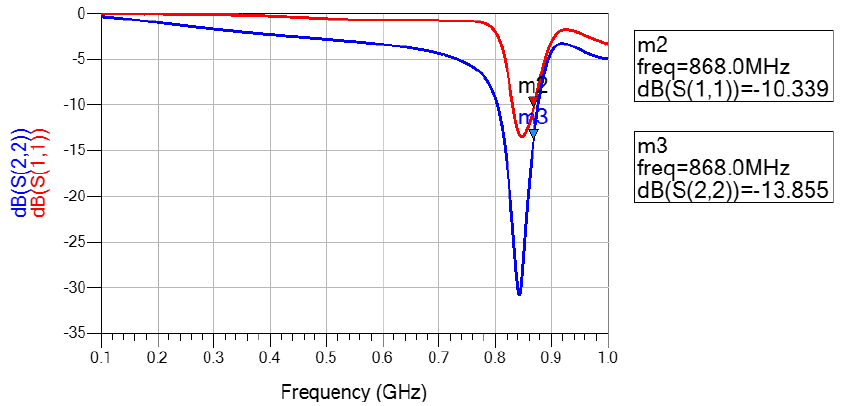
Figure 6. Input (S 11 ) and Output (S 22 ) reflection